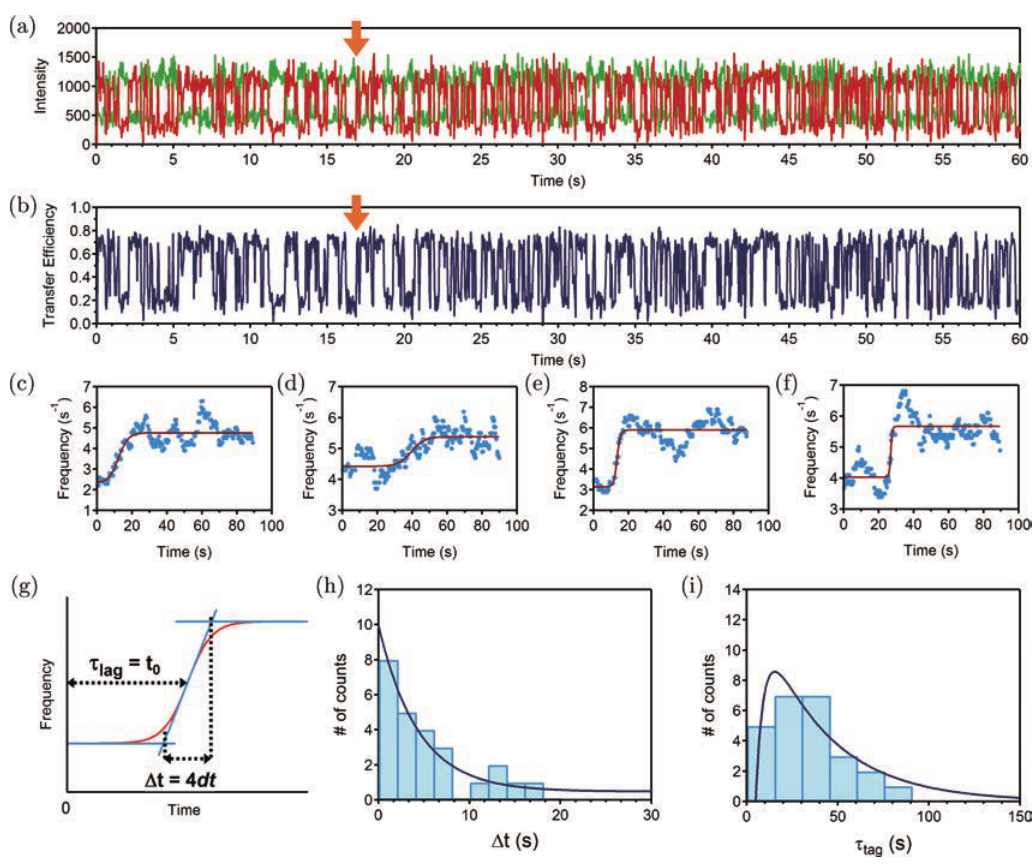
Fig. 4. (Color online) (a) Typical trace and (b) transfer e±ciency during the BamHI digestion process. The orange arrow shows the moment when BamHI is added. (c) – (f) Four representative traces of the turnover frequency. BamHI was added at time 0. (g) Fitting scheme of panels (c) – (f). Here (cid:1) t is the time interval for the enzyme to ¯nish the digestion reaction and (cid:2) lag is the time needed from the addition of BamHI to the midpoint of (cid:1) t . (h) Histogram of the time span for each transition ( (cid:1) t Þ . Dark blue curve is exponential ¯tting. (i) The distribution of the lag time ( (cid:2) lag Þ . Dark blue curve is the ¯tting to Eq. (6). (cid:2) for the serial events at the single-molecule level lag can be described as shown in Eq. (6) (Ref. 56): (cid:2) (cid:2) p ð (cid:2) Þ ¼ k k ð e (cid:3) k (cid:3) e (cid:3) k Þ = ð k (cid:3) k Þ : ð 6 Þ 1 lag 2 lag lag 1 2 2 1